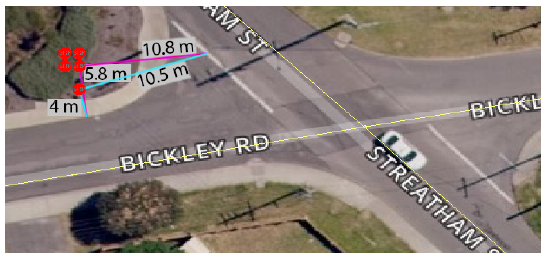
Figure 4. The illustration shows multiple data sets, as well as synthetic data (the group of four STOP signs) plotted on a geo-referenced image (sources: http://data.wa.gov.au (data);